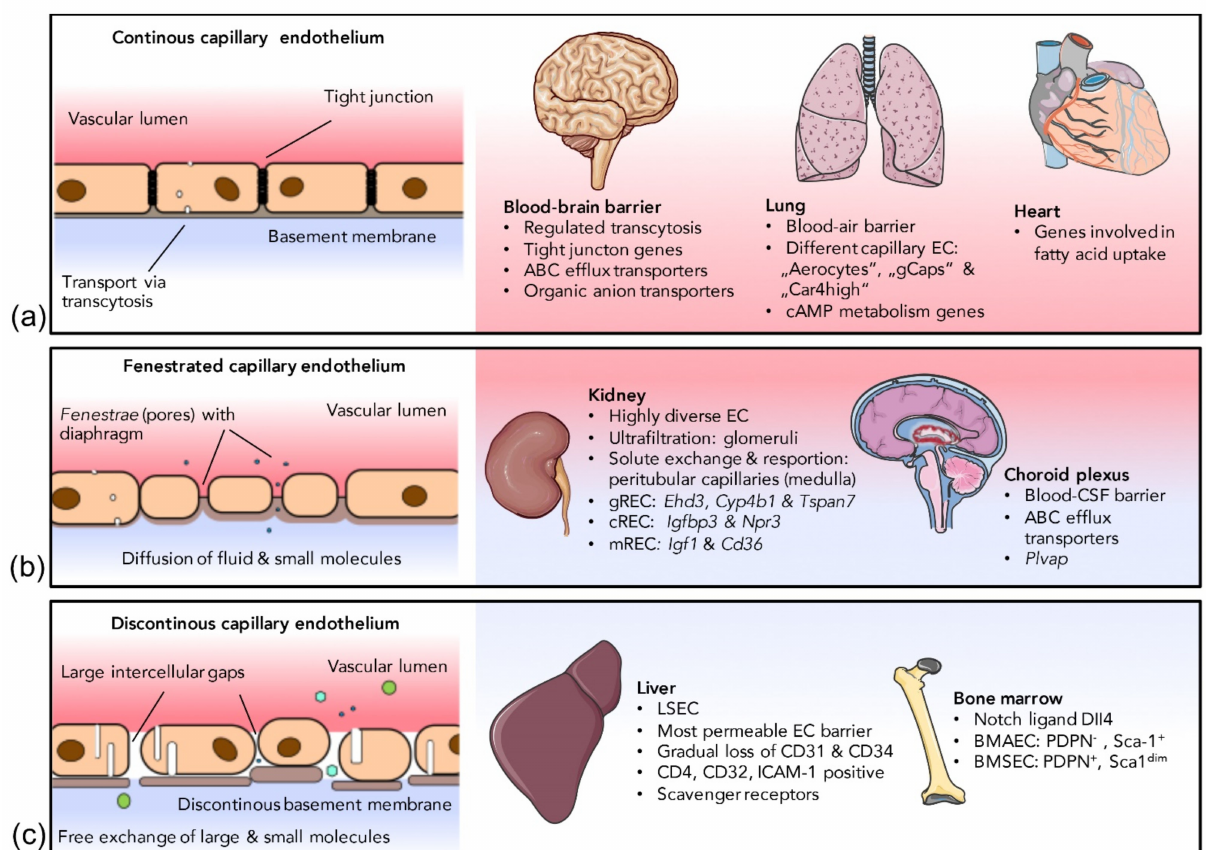
Figure 1. Three main types of capillary EC. ( a ) A tight continuous endothelium with a continuous basement membrane can be found in the capillaries of organs such as the brain, the lung and the heart. Molecules can pass the continuous endothelium by tightly regulated transcytosis. ( b ) The endothelium of the kidney and the choroid plexus is fenestrated and allows for diffusion of fluids and small molecules. ( c ) The capillary endothelium of liver and bone marrow is discontinuous with intercellular gaps and a discontinuous basement membrane, enabling free exchange of molecules. This figure contains artwork components of Servier Medical